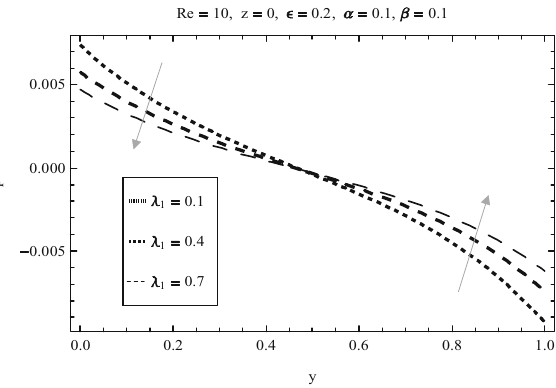
Fig. 16 Variation of p along y for different values of λ 1